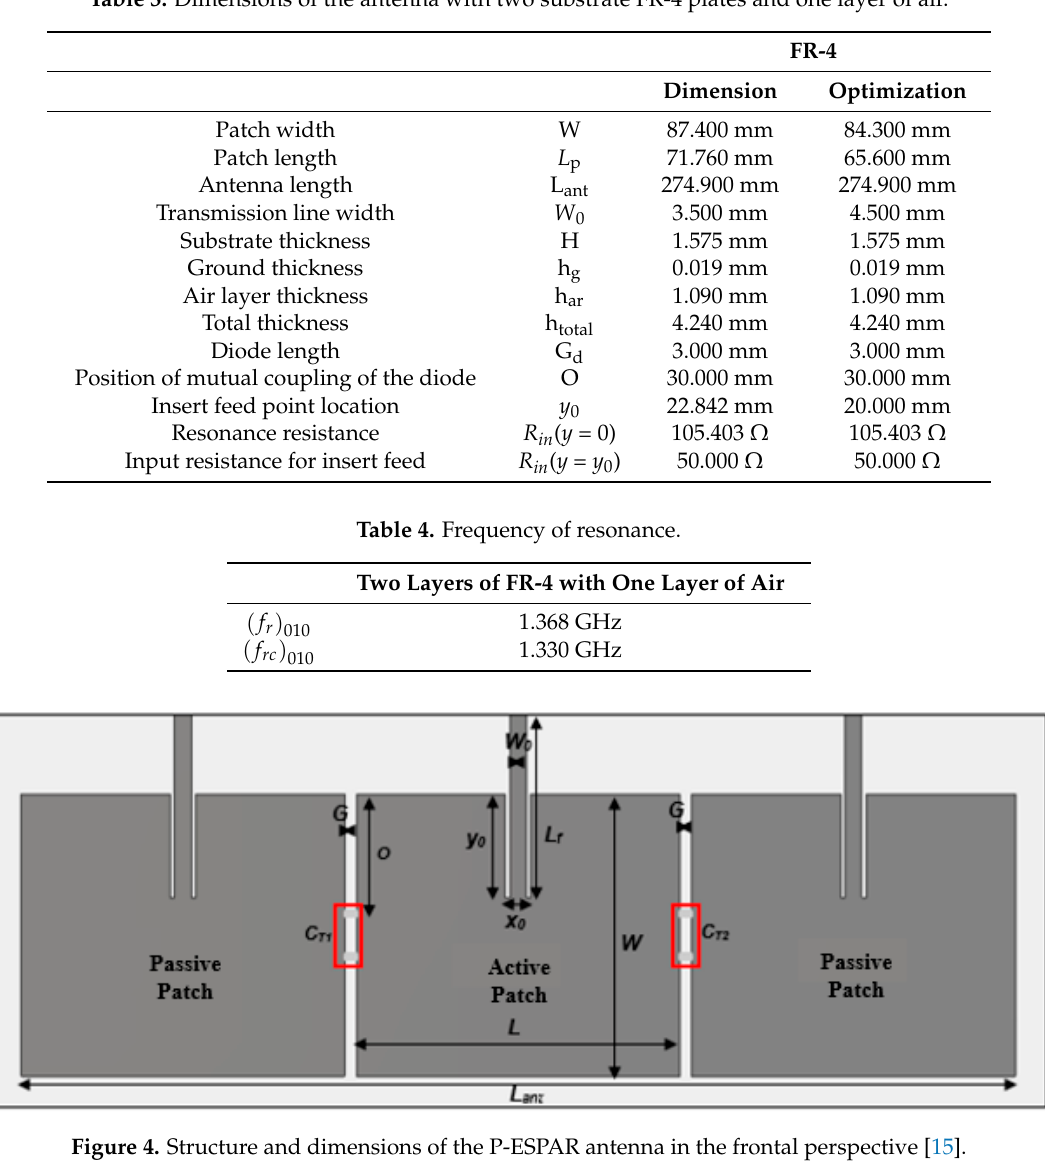
Table 3. Dimensions of the antenna with two substrate FR-4 plates and one layer of air.